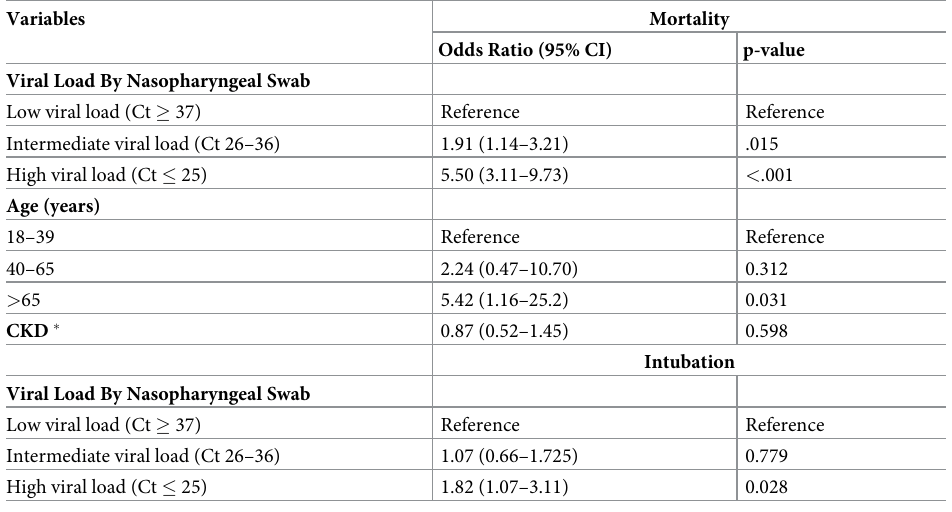
Table 2. Multivariate analysis of factors associated with in-hospital mortality and